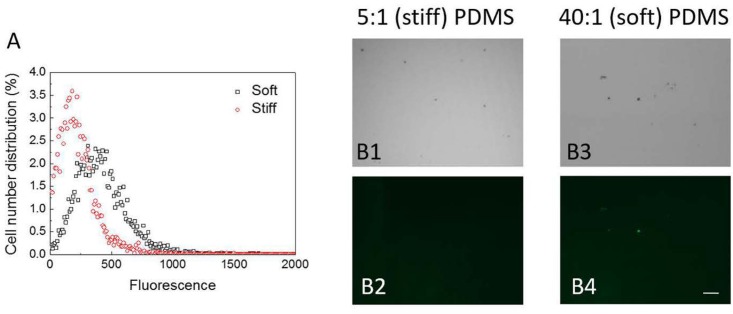
The intracellular c-di-GMP level in PAO1/pCdrA::gfps cells on soft (40:1) and stiff (5:1) PDMS surfaces after 2-h attachment. (A) Distribution of fluorescence signals measured by flow cytometry. (B) Representative images of PAO1/pCdrA::gfp(ASV)s cells attached on soft (40:1) and stiff (5:1) PDMS surfaces after 2-h attachment (Bar = 10 μm). B1 and B3: bright field images. B2 and B4: green fluorescence images.